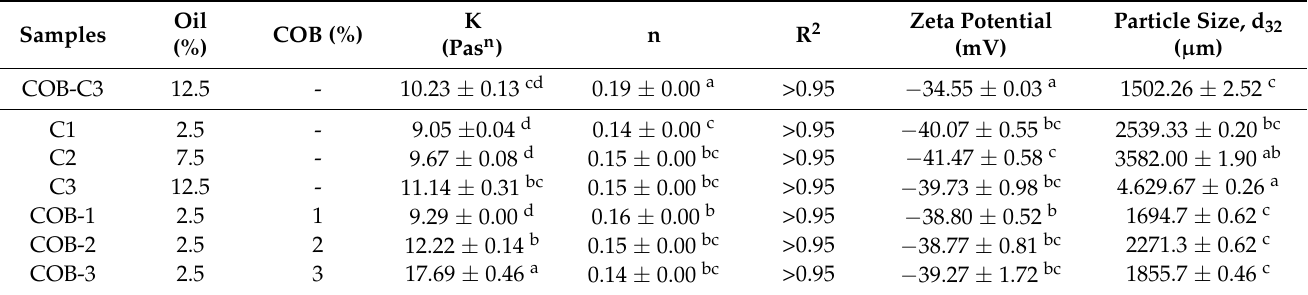
Table 2. Steady rheological properties, zeta potential, and particle size of plant-based ice cream